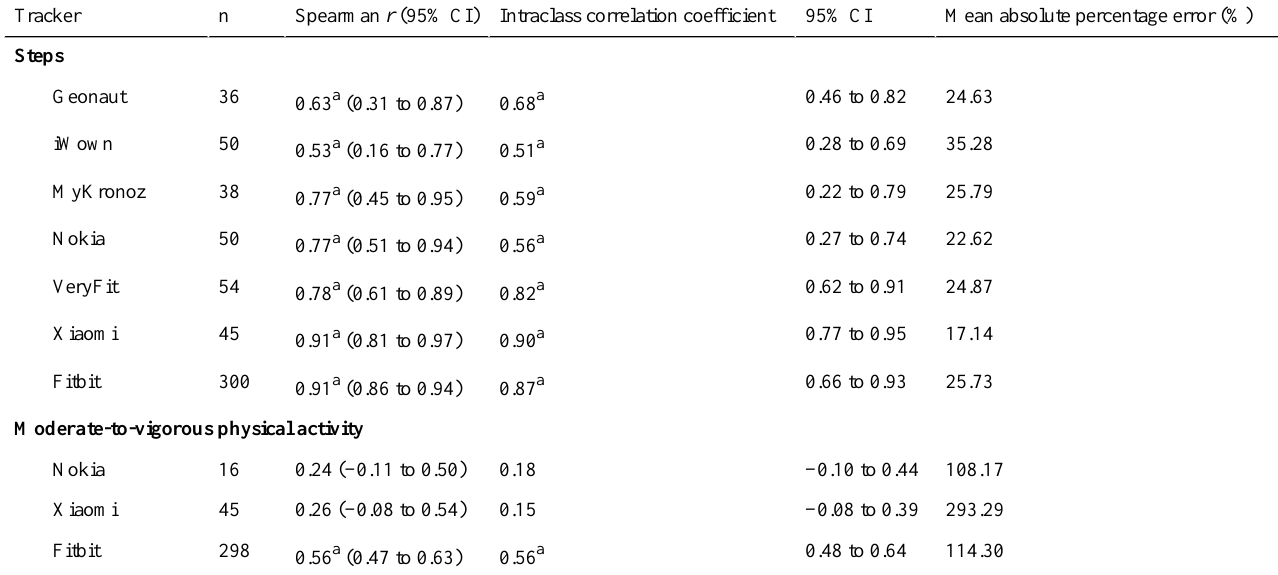
Table 2. Correlation coefficients, intraclass correlation coefficients, associated 95% CI of the measurements, and mean absolute percentage error scores for measuring steps and moderate-to-vigorous physical